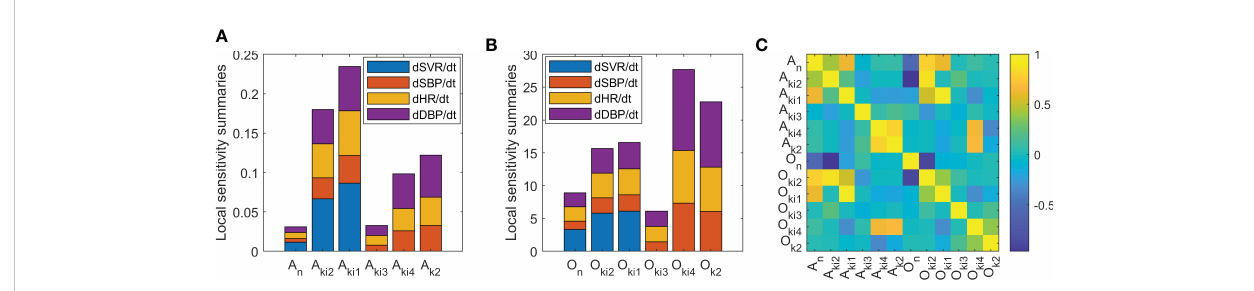
FIGURE 5 Sensitivity and identi fi ability analysis for Ta-dependent effect model of aspirin. (A) Local sensitivity summaries of A parameters. (B) Local sensitivity summaries of O parameters. (C) Correlation matrix between model